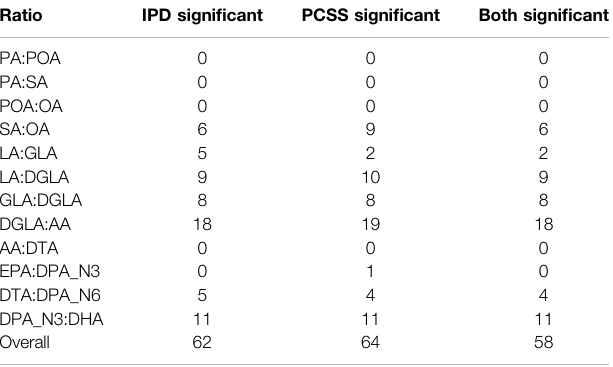
TABLE 4 | Summary of test decisions for a real data application calculating the linear model Fatty Acid Ratio ∼ snp + age + sex using individual participant data (IPD) and pre-computed summary statistics (PCSS) across 362,330 SNPs from 1,455 subjects in the Framing Heart Study ’ s Offspring and